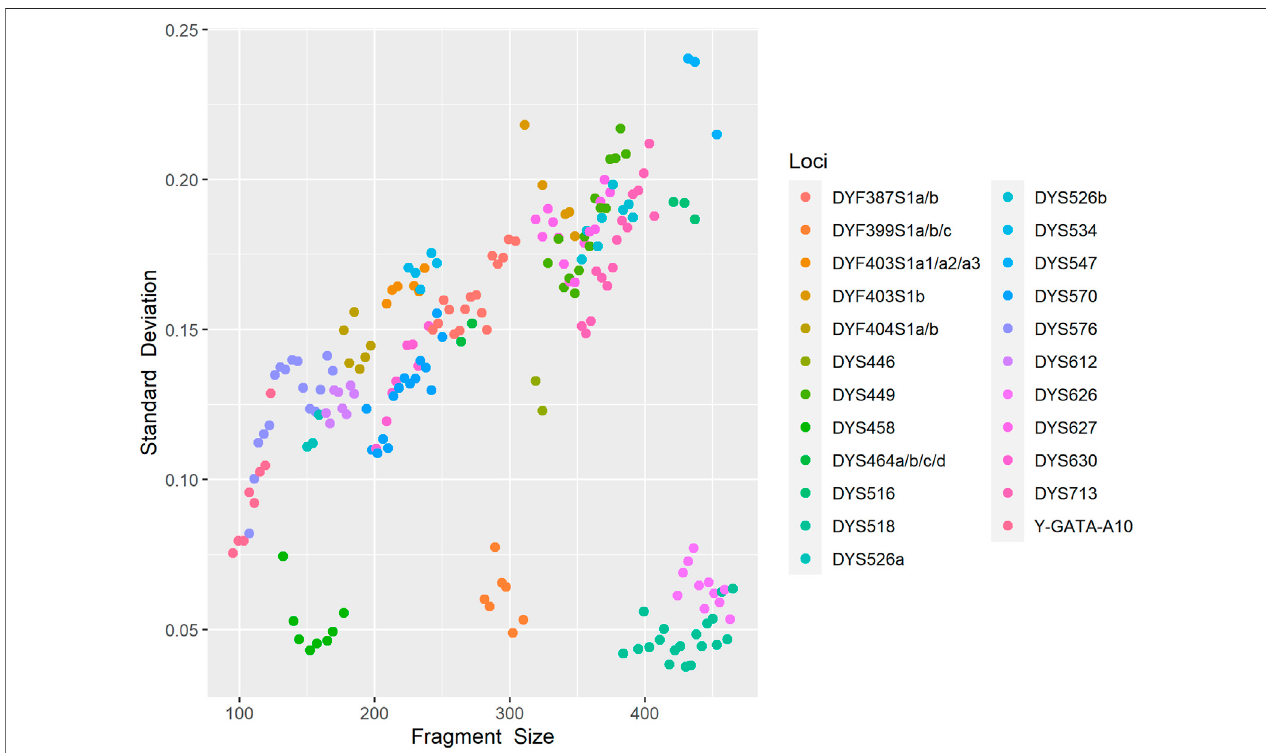
FIGURE 2 | Fragment size scoring variation for control allelic ladder of each locus detected on the 3500xL Genetic Analyzer in 24 replicated runs. Each point represents the standard errors of estimated fragment size for each locus.